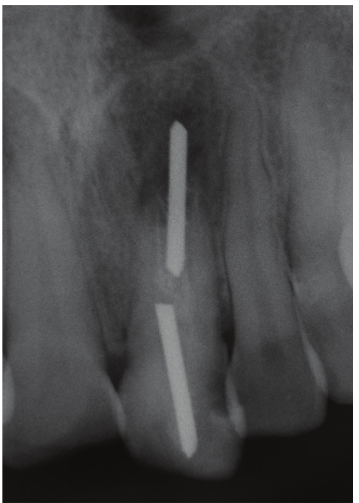
Figure 1: The initial radiograph showing the radiopaque body invading the periapical tissues.